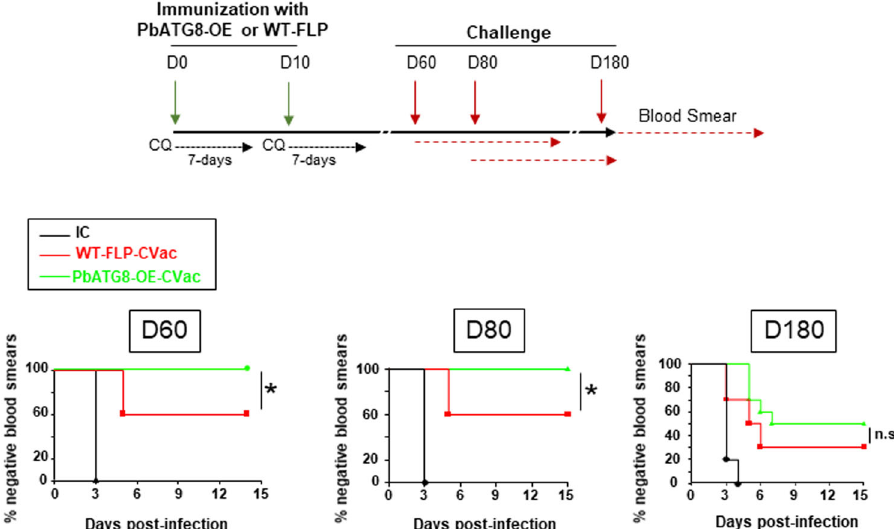
Fig. 4 PbATG8-OE-CVac elicit long-term protection in mice. Protocol for immunization with PbATG8-OE or WT-FLP parasites for memory time point challenge. Swiss-Webster mice immunized with two doses of 2 × 10 4 sporozoites of WT-FLP or PbATG8-OE parasites 10 days apart. Immunized mice were treated with chloroquine (0.8 mg/mouse) for 7 days starting with sporozoite immunization. Mice were then divided into three groups and challenged with 10 4 WT-Pb-ANKA sporozoites at memory time points D60 and D80 and D180 post-immunization prior to parasitemia determination by giemsa-stained thin blood smears from tail snip from D3 post-challenge until D15. Kaplan – Meier survival plots showing days to blood stage infection after challenge on D60, D80 and 6 months. Data are representative of experiment done in duplicate with fi ve mice in each group for D60 and D80, and 10 mice in each group for 6-month protection analysis. IC non-immunized infection control ( n = 5 each time). * p < 0.05, measured by log-rank Mantel – Cox